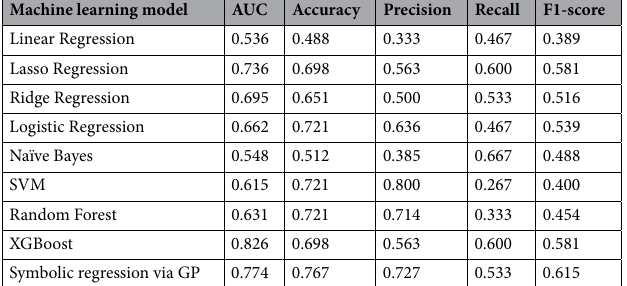
Table 5. Comparison of statistical metrics between nine machine learning models. Abbreviations: AUC, area under the curve of receiver operating characteristic curve; SVM, support vector machine; XGBoost, eXtreme Gradient Boosting; GP, genetic